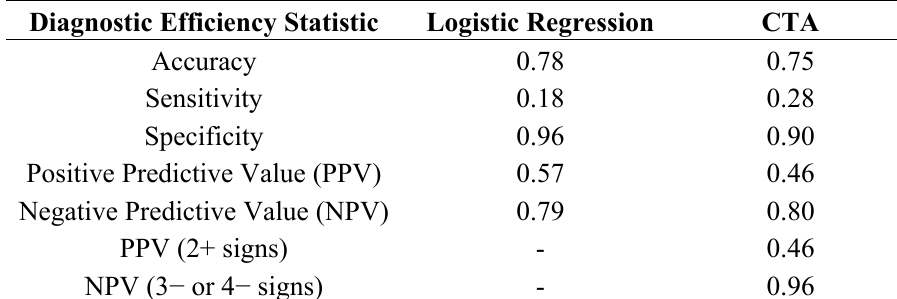
Table 2. Diagnostic efficiency statistics for logistic regression and classification tree analyses (CTA) ( N =